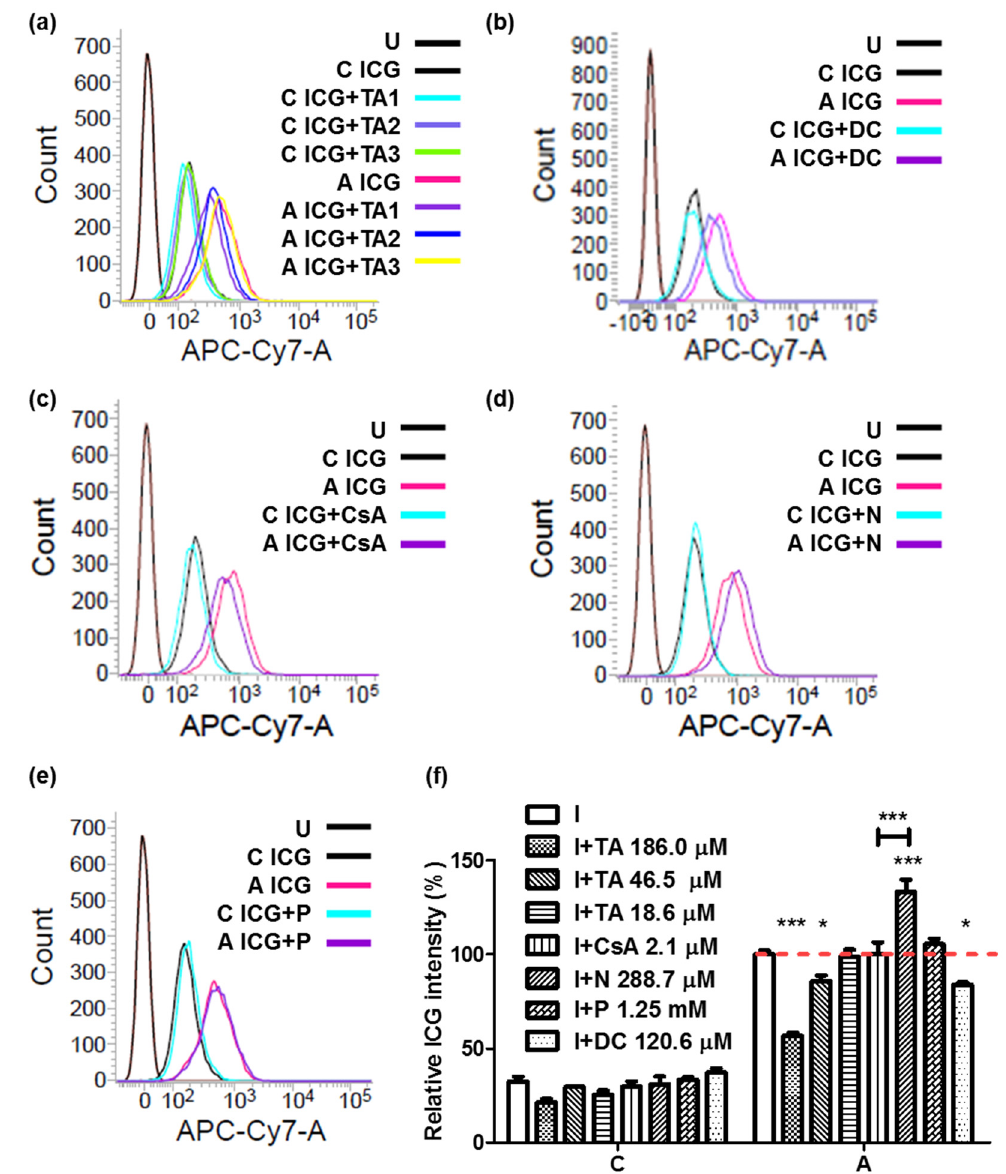
Figure 7. ICG-based drug-screening platform for ASBT through flow cytometry. ( a ) The selection of taurocholate (TA). TA1: 186.0 µ M. TA2: 46.5 µ M. TA3: 18.6 µ M. ( b ) The selection of deoxycholate (DC), ( c ) cyclosporine A (CsA), ( d ) Nifedipine (N), and ( e ) Primovist (P). ( f ) The quantification of data from flow cytometry. C: control cells. A: cells expressing ASBT. U: untreated. Red dash line: the 100% ICG intensity. Error bars show the SEM, where * p < 0.05 and *** p < 0.001.